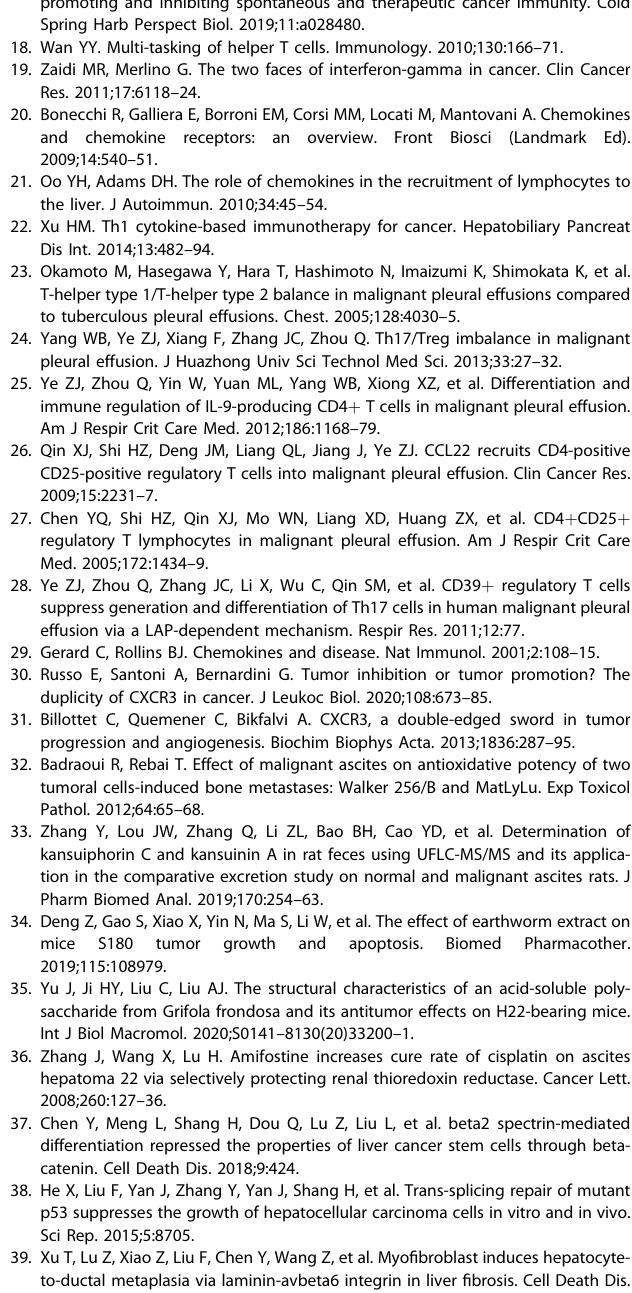
Fig. 6 CXCR3 plays a key role in the migration of Th1 cells into peritoneal cavity. A the representative fl ow cytometric dot plots of Th1 cells in peritoneal fl uid and peripheral blood from WT and CXCR3 − / − mice at 14 days after intraperitoneal injection of H22 cell; B the ascites- peripheral blood gradient of Th1 ratio from WT and CXCR3 − / − mice at 14 days after intraperitoneal injection of H22 cell. The difference between two groups was determined by t test; C representative fl ow cytometric dot plots of Th1 cells in peritoneal fl uid and peripheral blood from WT and CXCR3 − / − mice at 14 days after intraperitoneal injection of S180 cell; D the ascites-peripheral blood gradient of Th1 ratio from WT and CXCR3 − / − mice at 14 days after intraperitoneal injection of S180; the difference between two groups was determined by t test; E immunohistochemical staining revealed that a decrease of Th1 cells (CD4 + IFN- γ + ) in visceral peritoneum of CXCR3 − / − mice compared with wild-type mice; F Graphical summary of present research: CXCL9,10/CXCR3 axis mediated the recruitment of Th1 cells into peritoneal cavity, interferon γ secreted by Th1 cells in peritoneal fl uid suppressed the growth of tumor cells. In addition, interferon γ reduced peritoneal permeability via VEGF and Ang-2. * p ≤ 0.05, ** p ≤ 0.01, *** p ≤ 0.001, ns no signi fi cant; scale bars = 50 μ